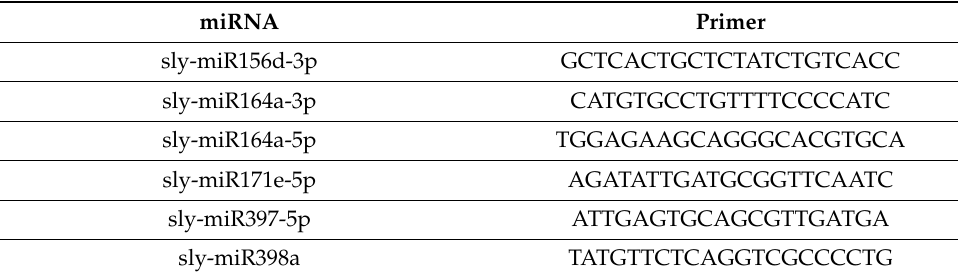
Table A2. Primers Used for miRNA